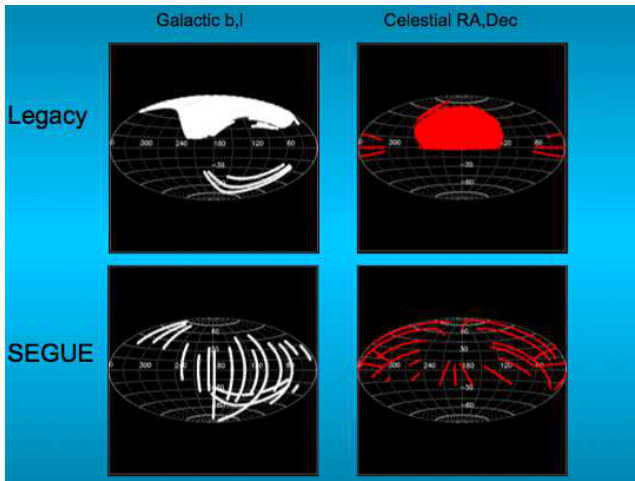
Figure 1: The sky coverage of the Legacy and SEGUE surveys in galactic (left) and celestial (right) coordinates, from